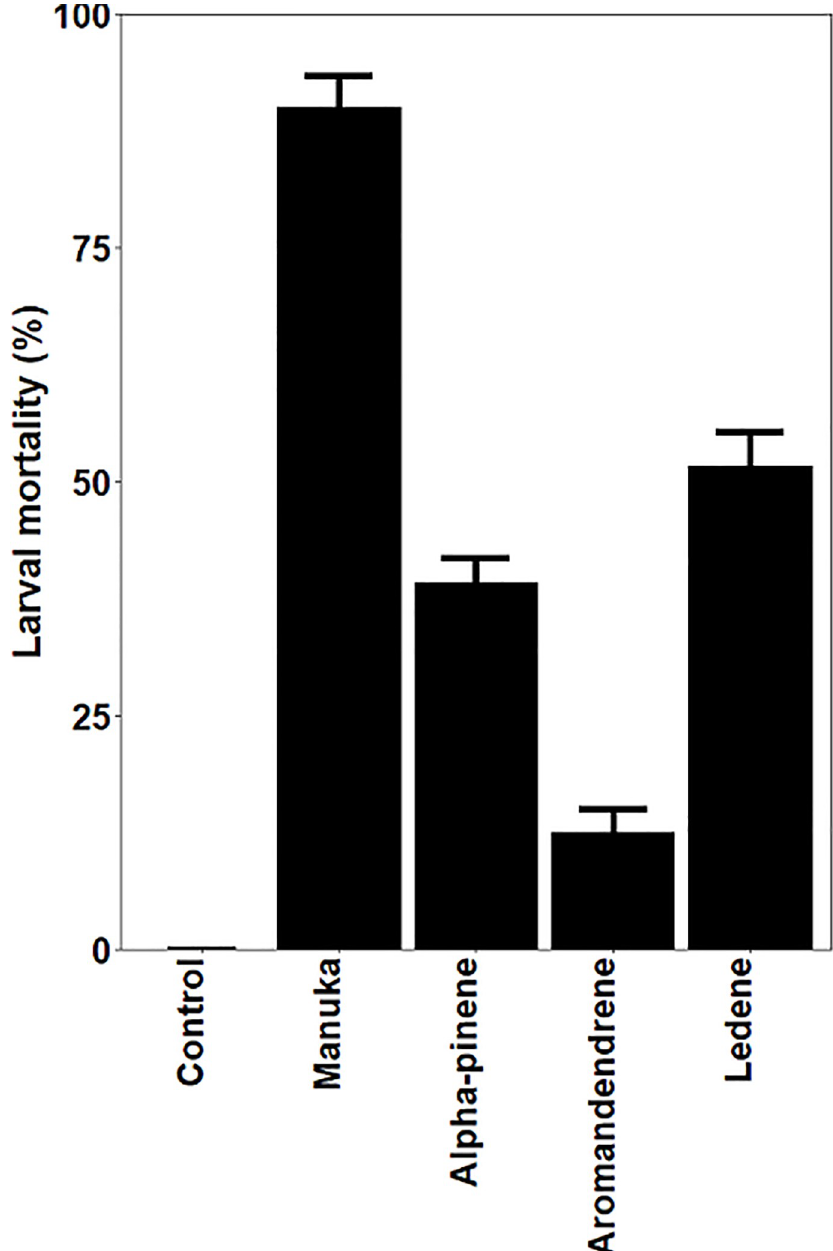
Fig 2. Toxicity of three chemical constituents of manuka ( L . scoparium ) essential oil against Aedes aegypti larvae relative to whole essential oil. Error bars represent the standard error of the mean. compounds with LC < 100 mg/L to exhibit a significant larvicidal effect. Cheng et al. [34] 50 considered compounds with LC < 50 mg/L highly active, 50 mg/L < LC < 100 mg/L active, 50 50 and LC > 100 mg/L inactive. Based on these criteria, L . scoparium essential oil and three of its 50 four fractions can be considered active/highly active. Moreover, the use of Hex-Am emulsifier enhanced the toxicity of L . scoparium essential oil against the mosquito larvae. These findings